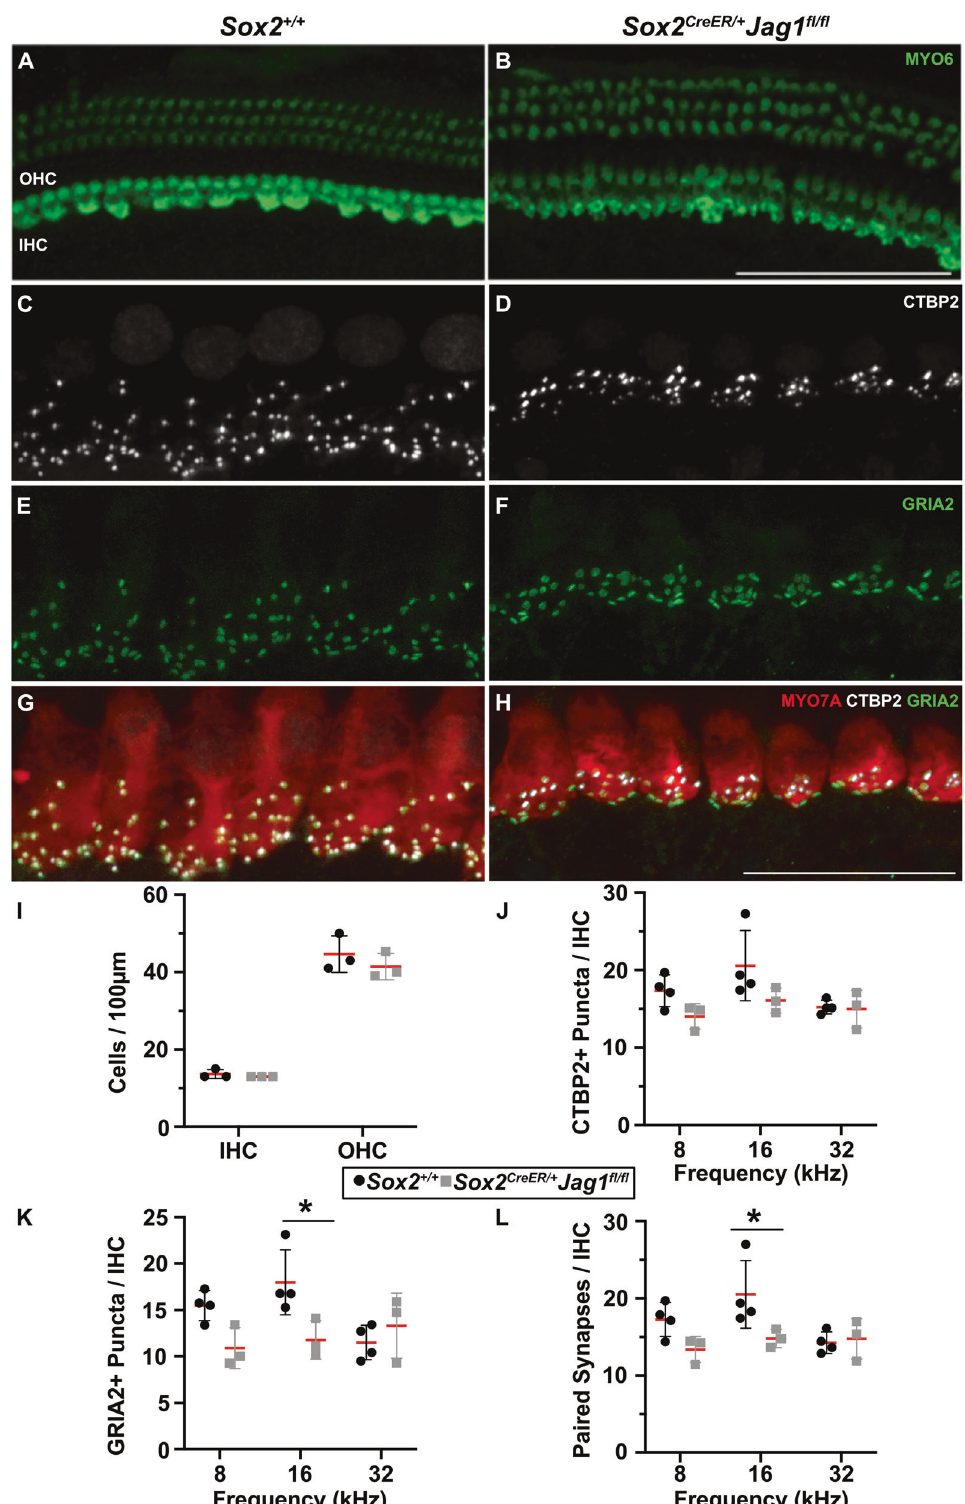
conduction and demyelination of the auditory nerve would alter the peak latencies of the ABR waveform [28, 29]. To determine the effect of JAG1 deletion on auditory nerve conductance, we plotted absolute latencies of wave I of the 16 kHz ABR waveform at 6 weeks [30]. ABR wave I absolute latencies in Sox2 CreER/ + Jag1 fl / fl mice (Fig. 3D, gray squares) was not signi fi cantly different from